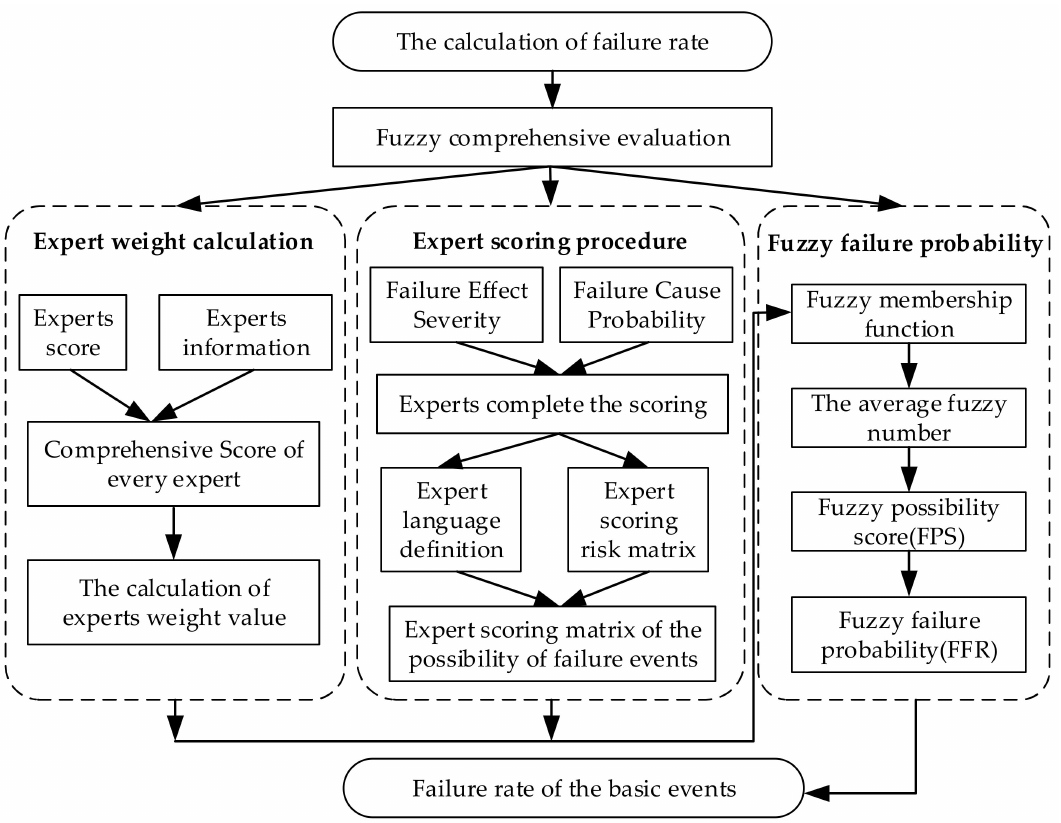
Figure 3. A framework of fuzzy comprehensive evaluation